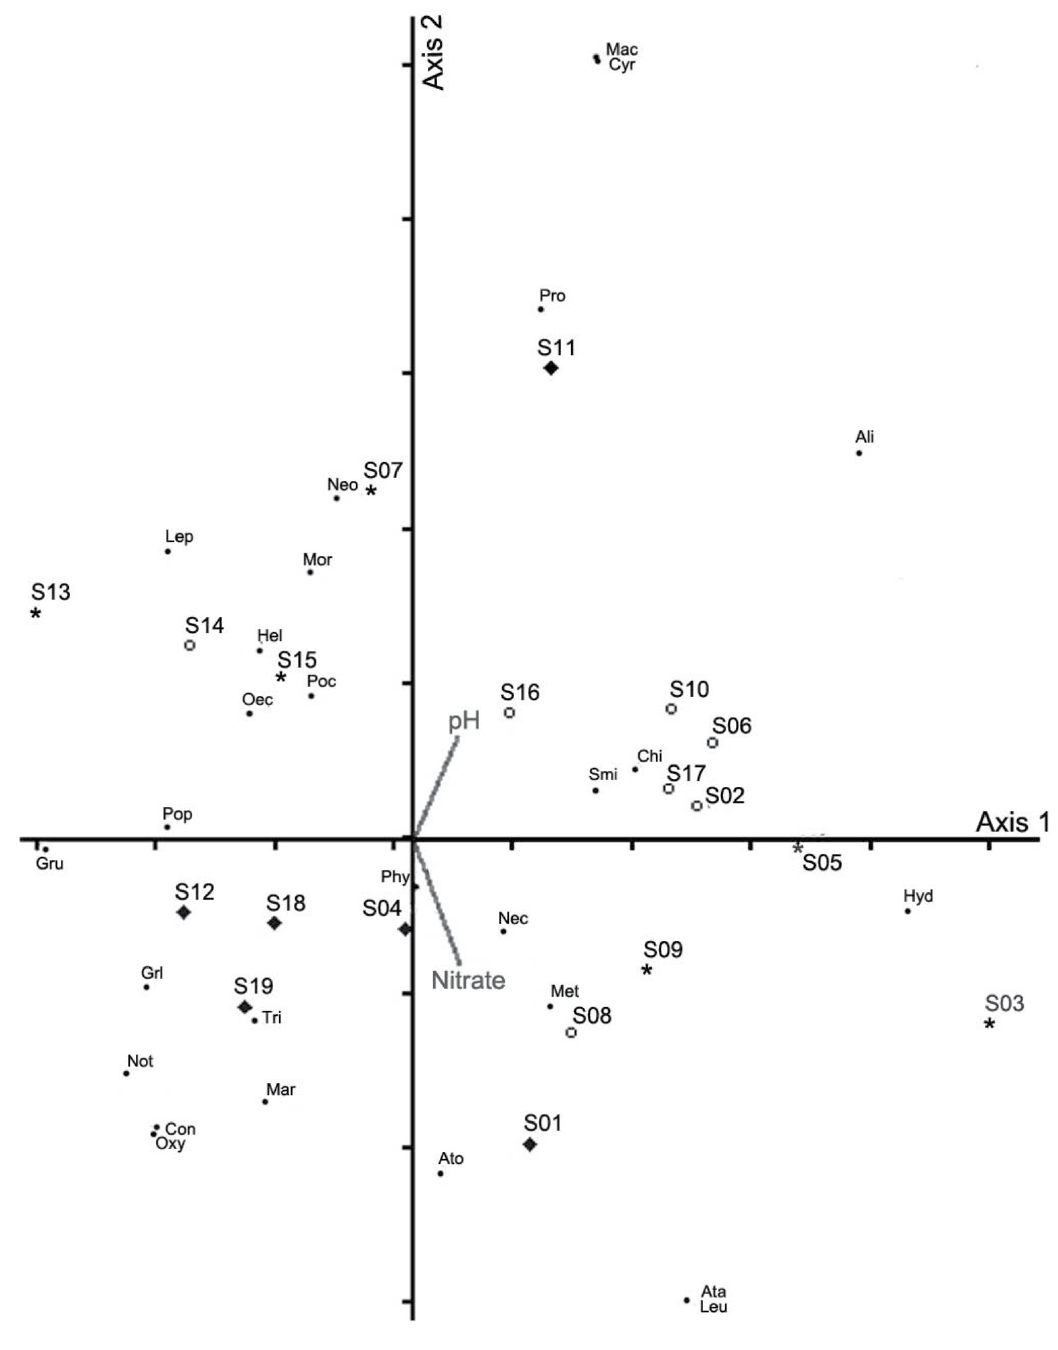
Figure 3. Canonical Correspondence Analysis (CCA) performed to 19 sites studied and environmental parameters at Serra da Bocaina Mountain. Axis 1 and 2. ♦ reference streams, * intermediate streams, ○ poor